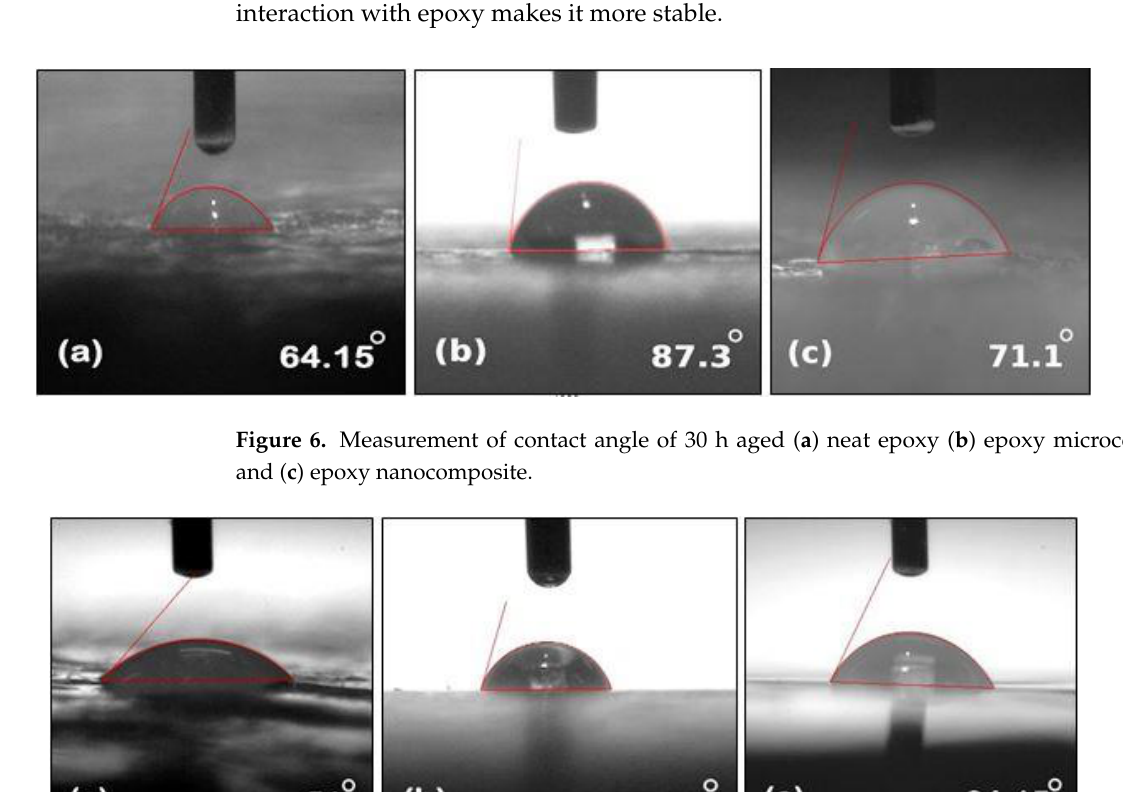
Figure 7. Measurement of contact angle of 60 h aged ( a ) neat epoxy ( b ) epoxy microcomposite, and ( c ) epoxy nanocomposite.